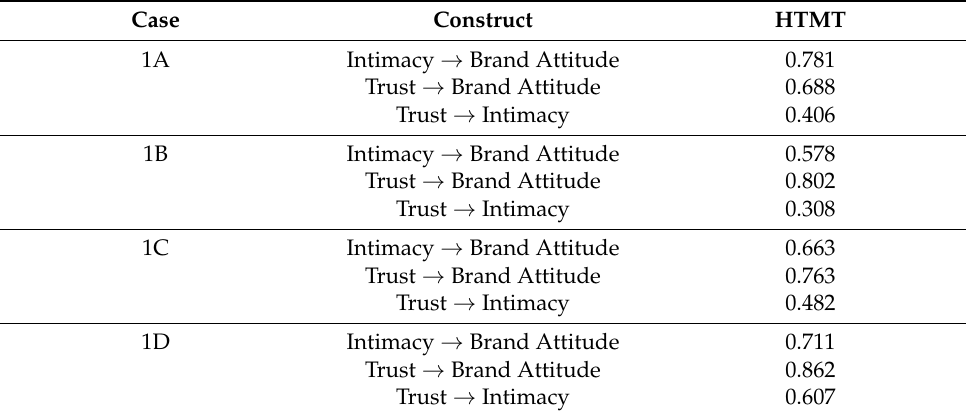
Table A5. Discriminant Validity of each case in Delivery Service Scenario.